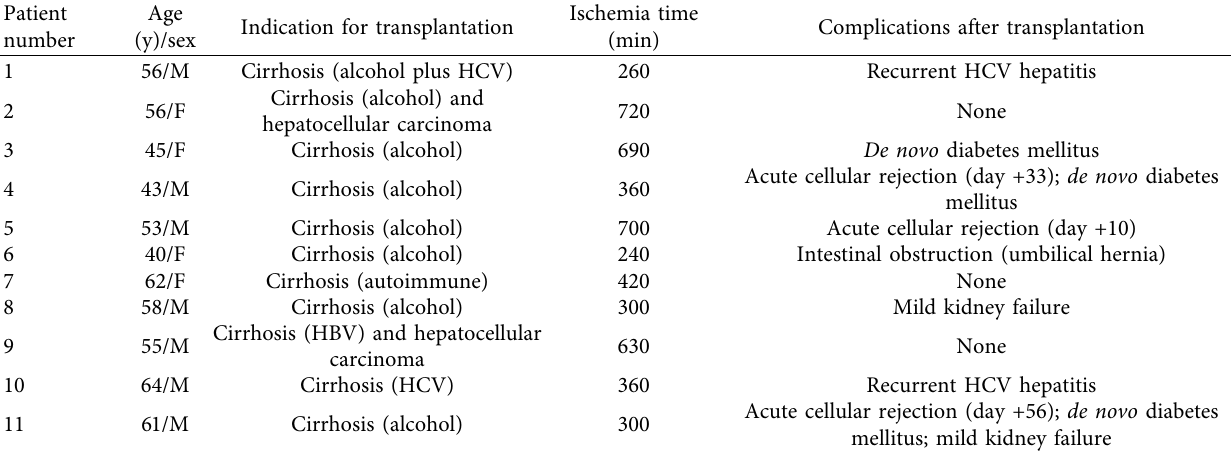
Figure 1: Schematic representation of K18 cleavage during apoptosis and the epitopes recognized by the assays for K18 fragments employed in the present study. The TPS assay can detect soluble full-length K18 as well as K18 fragments; increased serum TPS concentrations could, therefore, represent necrosis or apoptosis. Conversely, the M30 assay detects a neoepitope that is only revealed after caspase cleavage of the protein and is postulated to be a selective biomarker of apoptosis. [13, Table 1: Patient characteristics.